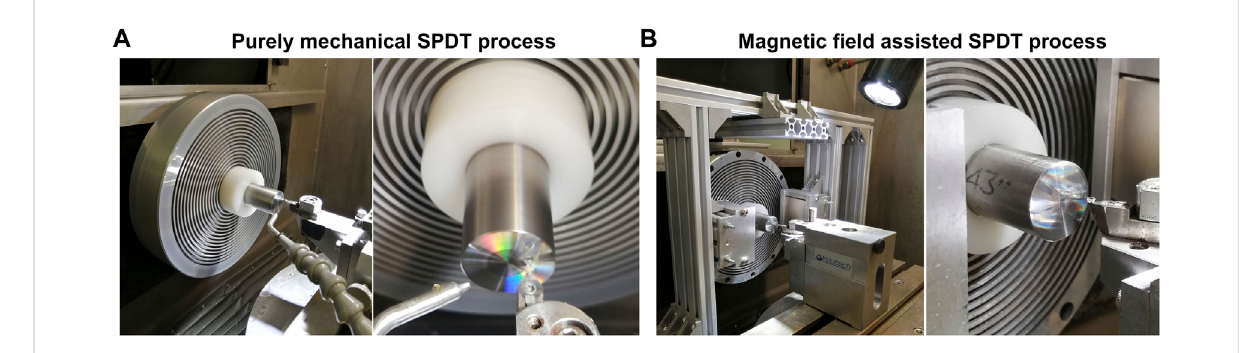
FIGURE 5 Experimental stand of the machining tests: (A) Purely mechanical SPDT platform; (B) Magnetic fi eld assisted SPDT platform.